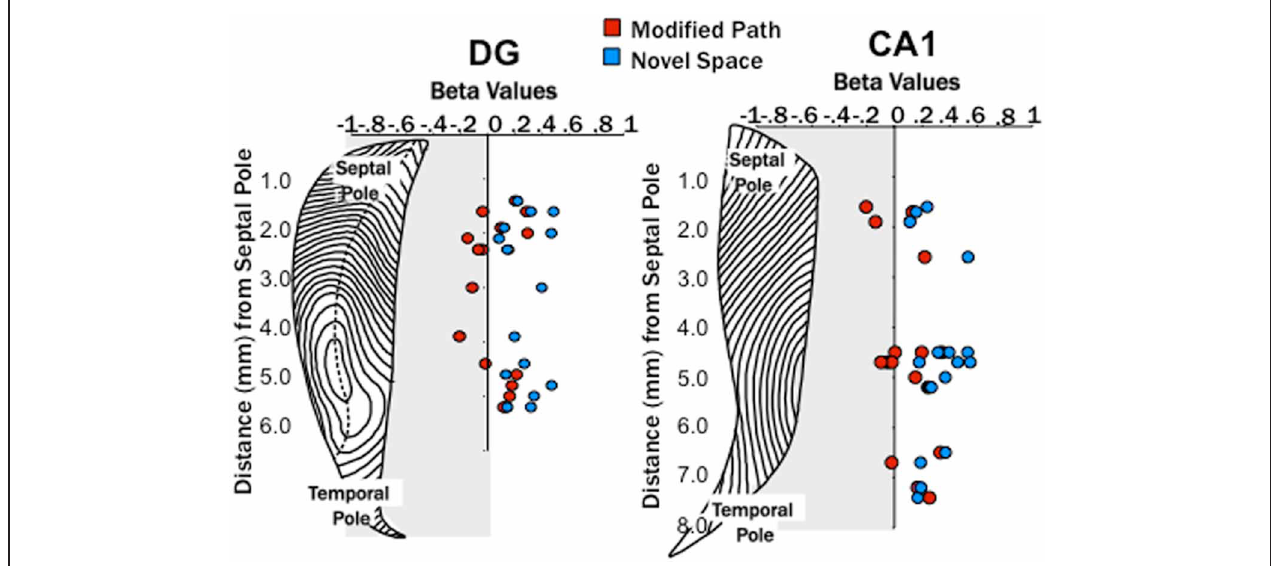
the power of fast gamma power (65–100Hz) on the modified path (red) and novel space (blue) from the familiar condition when controlled for speed. Changes in gamma power at DG and CA1 sites did not differ significantly along the septo-temporal axis.